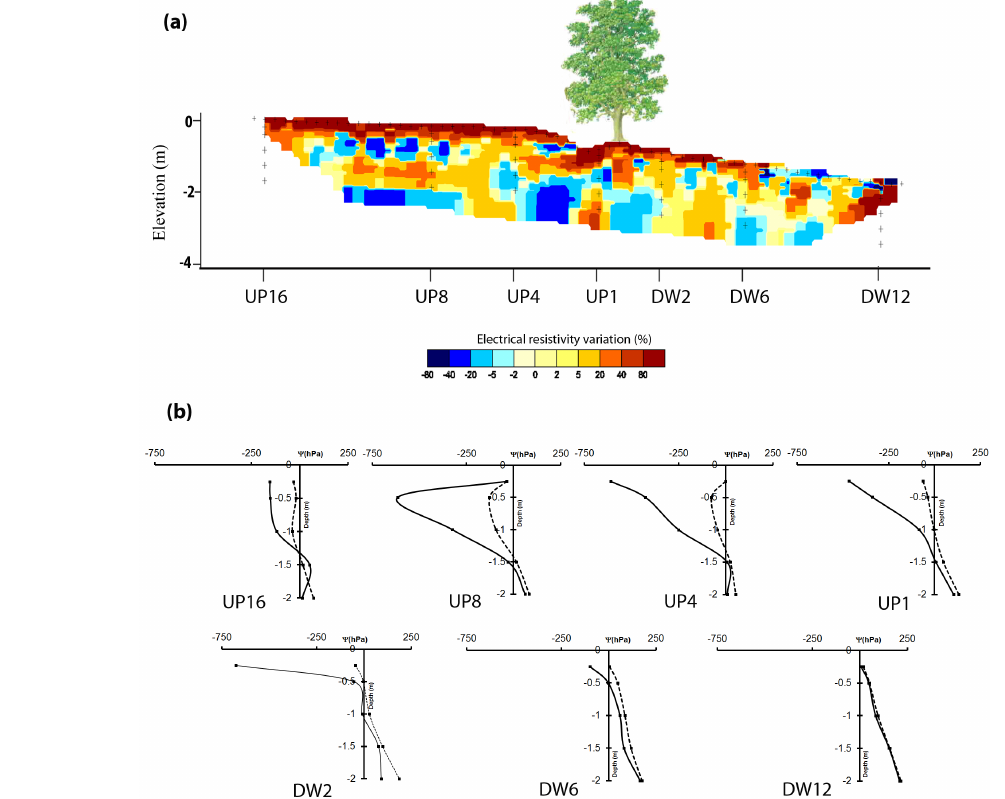
Figure 5. Relationship between ER and soil dryness at the hedgerow proximity. (a) Variation (%) in electrical resistivity from the wettest state (T06) to the driest state (T10). (b) Measured soil matric-potential profiles at seven locations: UP16, UP8, UP4 and UP1 for upslope and DW2, DW6 and DW12 for downslope. Dashed lines indicate the wettest state (T06) and solid lines the driest state